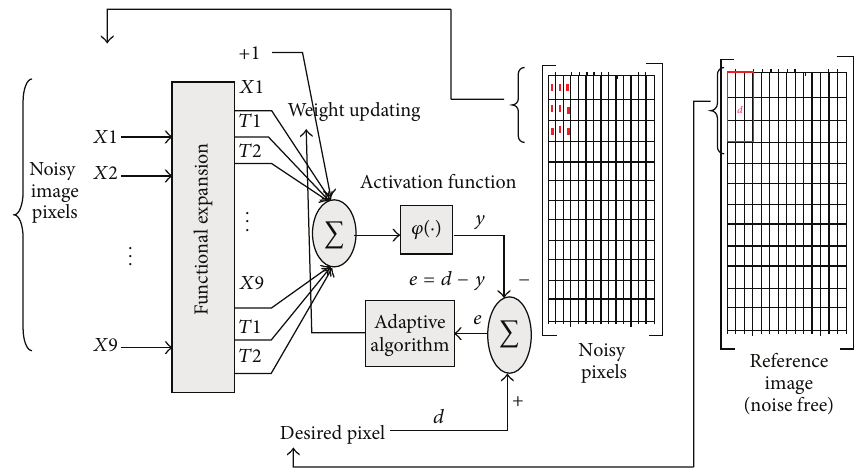
Figure 1: Structure of FLANN-LMS or CS-FLANN filter.